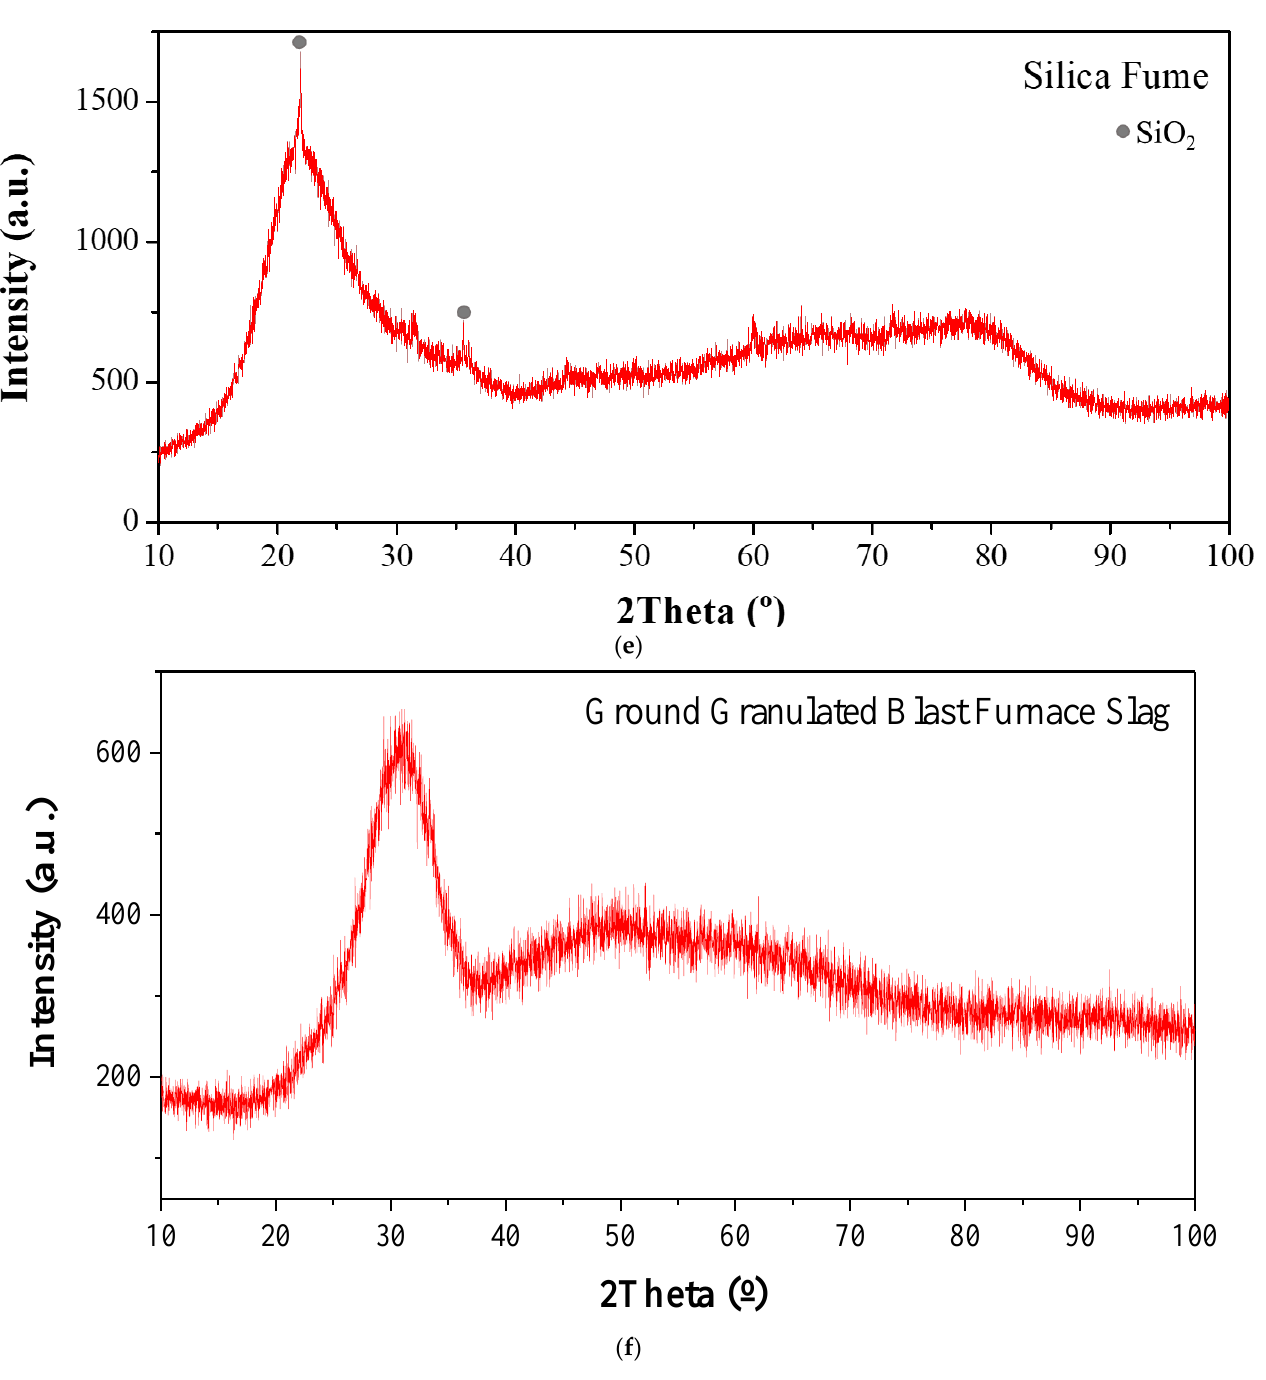
Figure 7. XRD diagram ( a ) bauxite, ( b ) chamotte, ( c ) ground granulated blast furnace slag, ( d ) iron silicate, ( e ) silica fume, ( f ) steel slag.